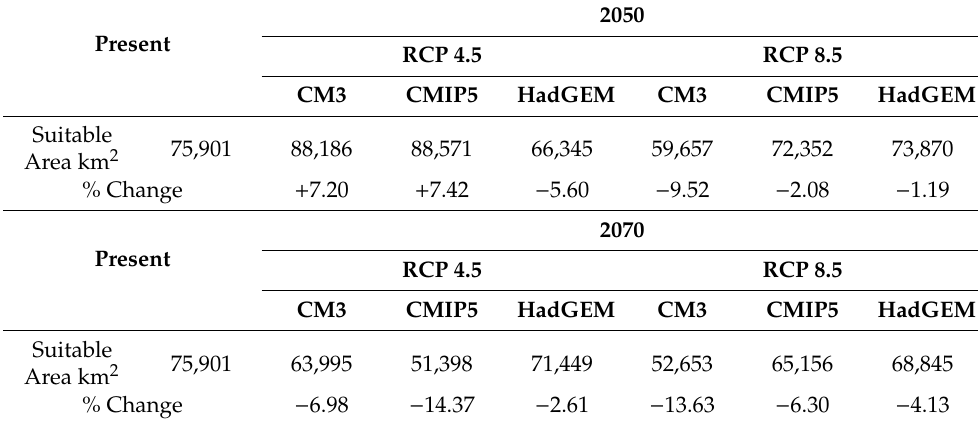
Table 2. Percent change of geographic distribution for Manihot walkerae between the current model and the future projected climate change models for the years 2050 and